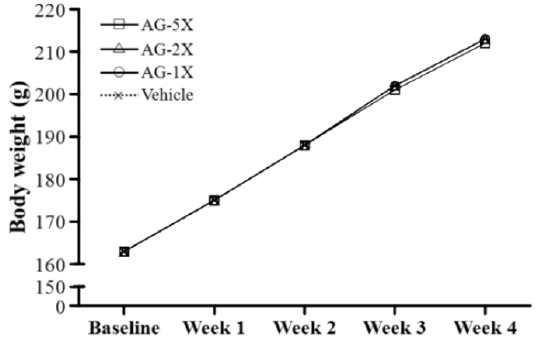
Figure 1. The changes of body weight of rats supplemented with vehicle, 250, 500 and 1250 mg/kg AG (AG-1X, AG-2X and AG-5X) for 28 days. Data are mean ± SEM for n = 8 rats per